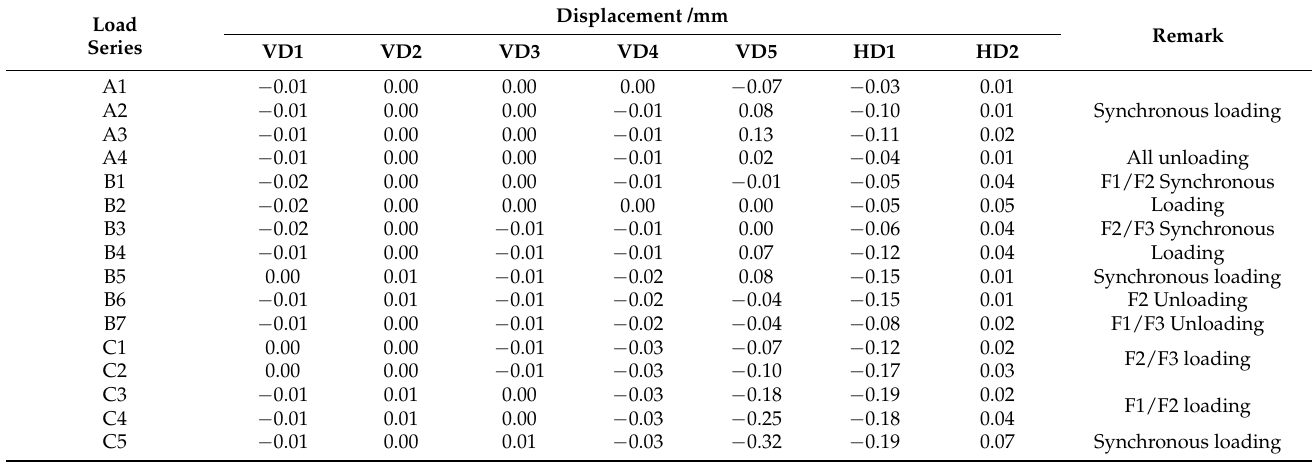
Table 4. Displacement of measuring points.